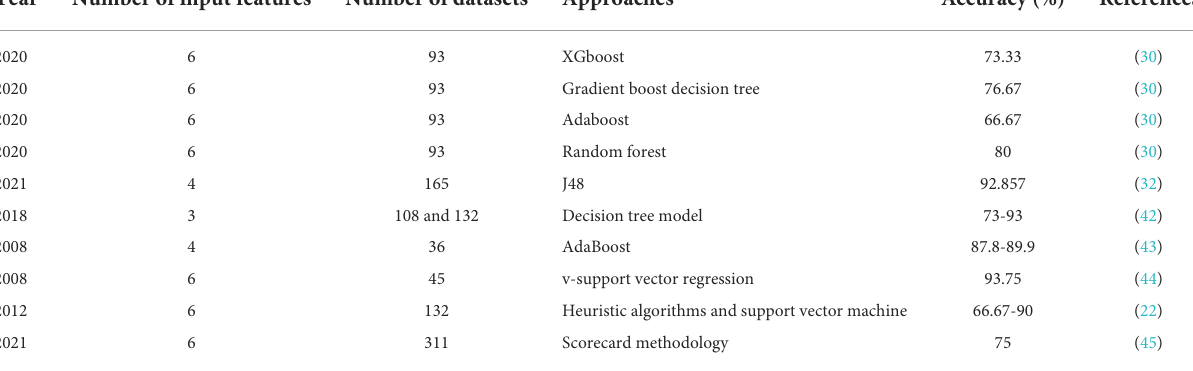
TABLE 1 Summary of previously published literature to predict